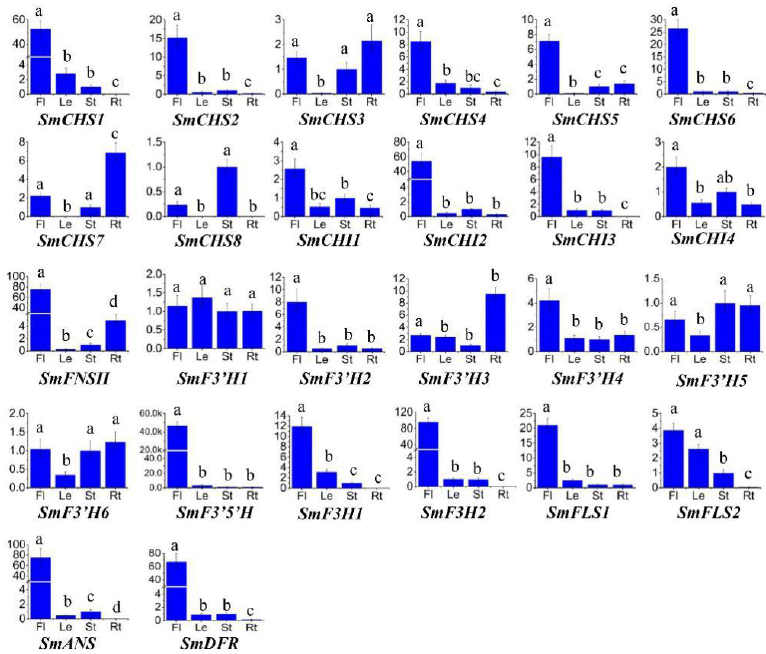
Figure 3. Tissue-specific expression of flavonoid biosynthesis-related genes. The levels of transcripts in flowers (Fl), leaves (Le), stems (St) and roots (Rt) of S. miltiorrhiza were analyzed using quantitative real-time reverse transcription-PCR method (qRT-PCR). p < 0.05 was considered statistically significant and represented by different letters appeared above each bar.